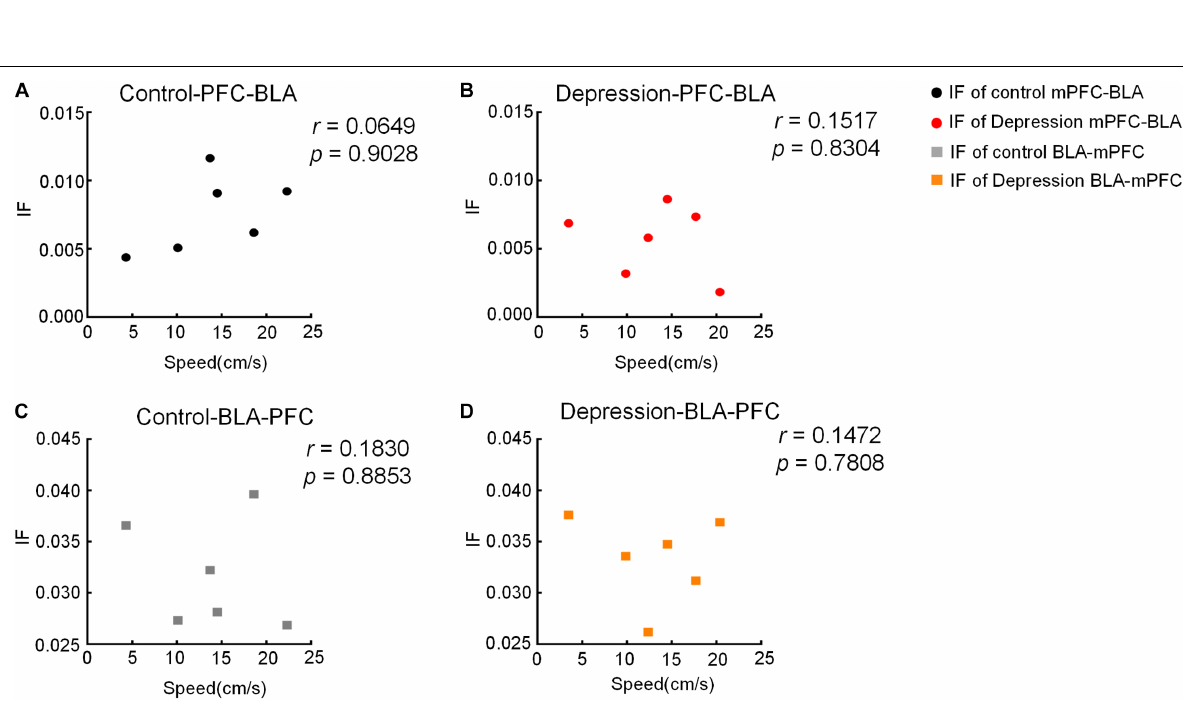
FIGURE 9 | Correlation between moving speed and DTF in the OFT. (A,B) There is no significant correlation between moving speed and DTF of the mPFC in the (A) control and (B) depression group. (C,D) There is no significant correlation between moving speed and DTF of the BLA in the (C) control and (D) depression group.